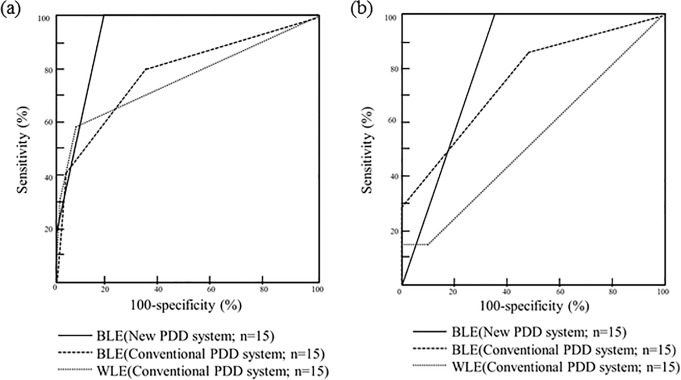
Diagnostic capacity.(a) The AUC of the new PDD system was significantly superior to that of the conventional PDD system in blue light (fluorescence) mode for all regions (p<0.05). (b) The AUC of new PDD system was significantly superior to that of the conventional PDD system in blue light (fluorescence) mode in the distal bladder (p<0.05).